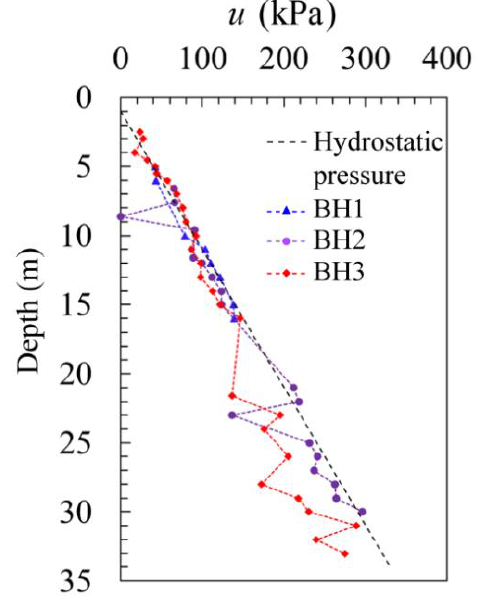
Figure 7. Pore water pressure.